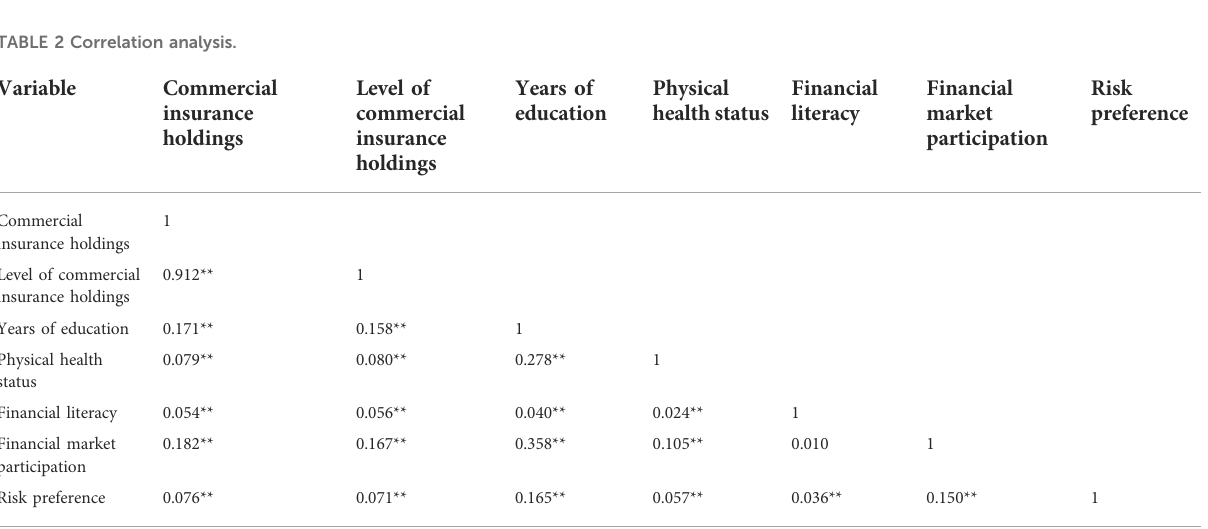
TABLE 2 Correlation